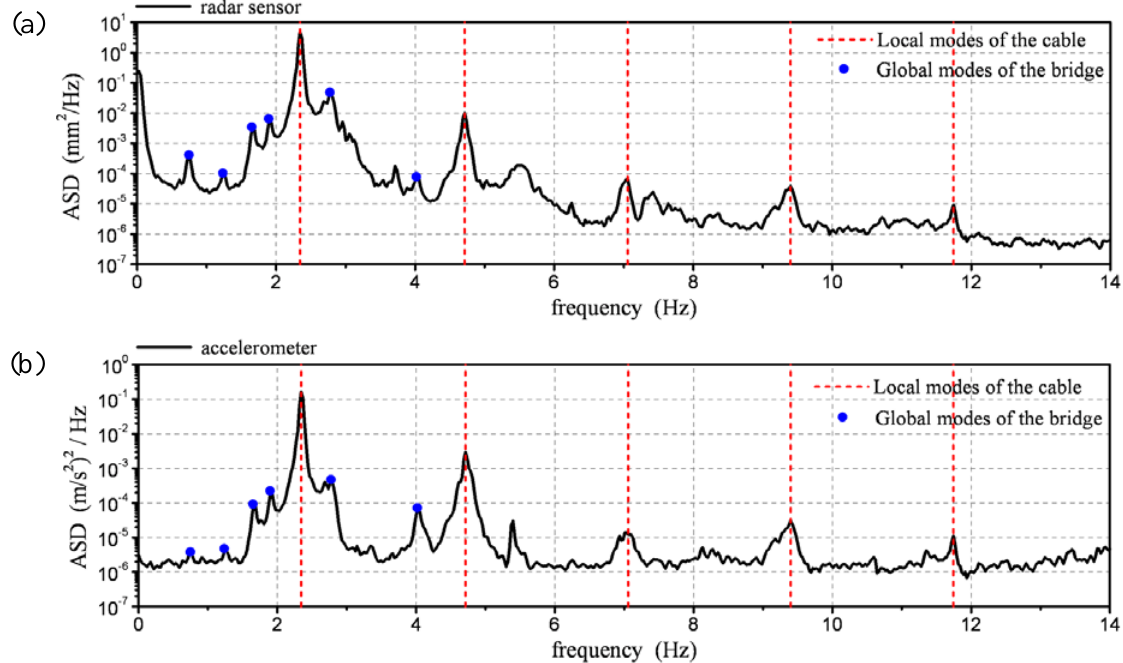
: (a) Auto-spectrum of the displacement data measured by the Figure 5. Stay-cable S' 12 radar; (b) Auto-spectrum of the acceleration data measured by the conventional